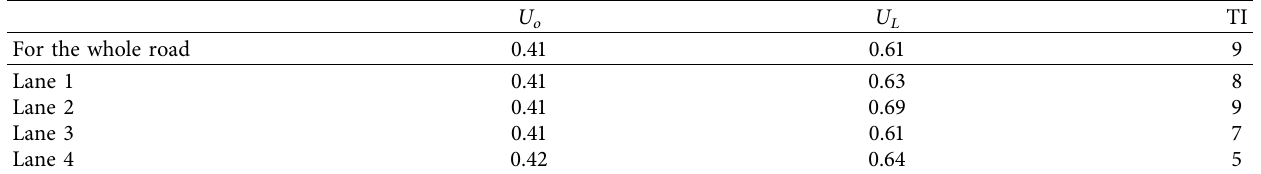
Table 4: DIALux simulation results using the imported measured IES file for the prototype street light obtained by a TAF certified type C mirror goniophotometer. U o U L TI For the whole road